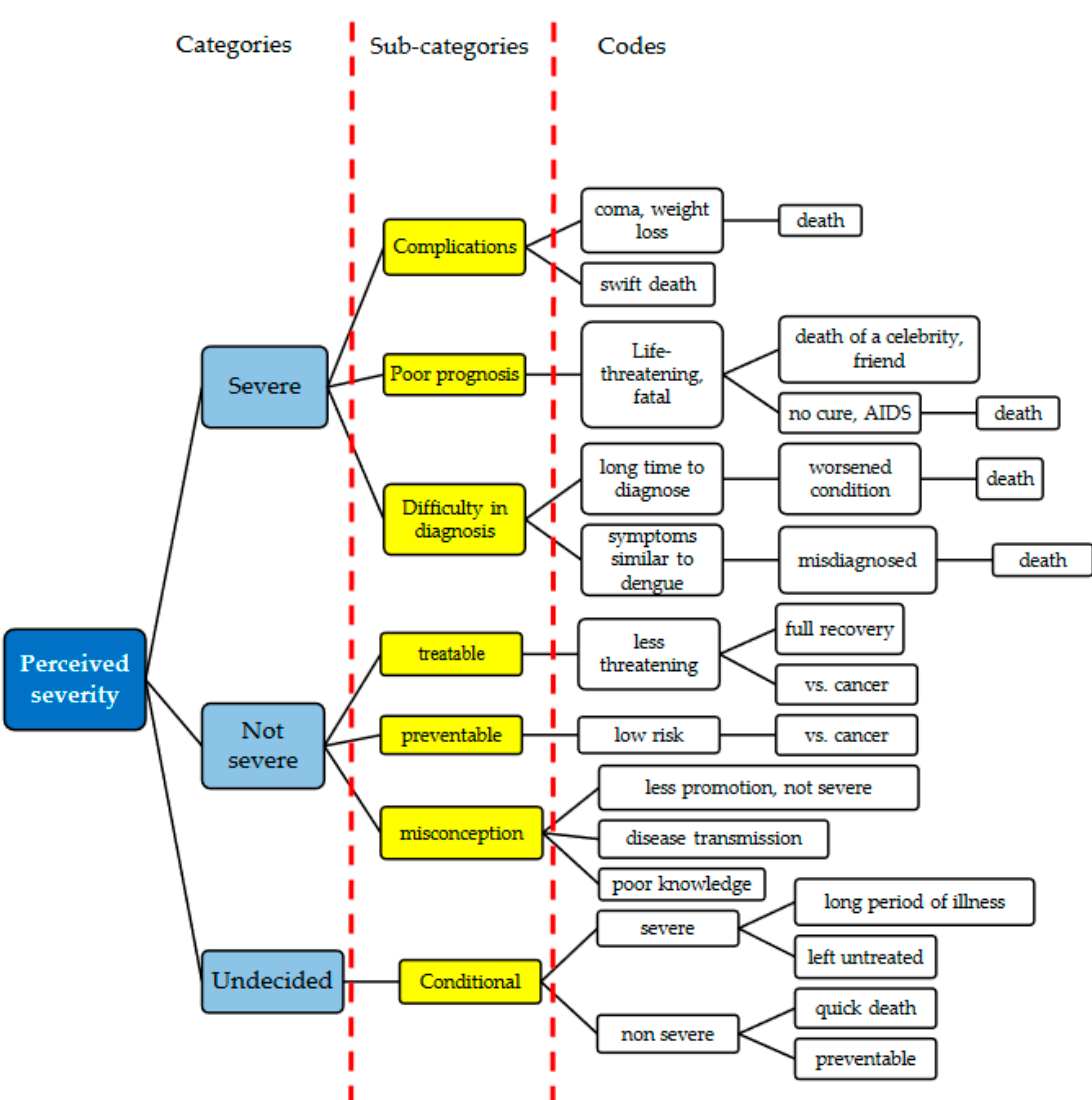
Figure 1. Mapping of the categories, sub-categories and codes pertaining to the perceived severity on leptospirosis infection.